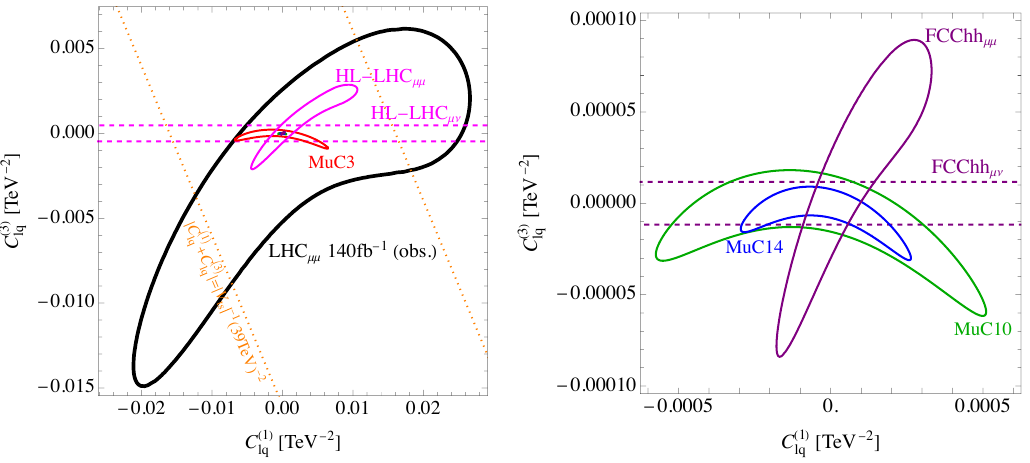
Figure 6 . Sensitivity reach (95% CL) for the quark flavour-universal scenario on the two EFT coefficients C (1) and C (3) , in TeV − 2 , for different colliders. The right plot is a zoomed-in version lq lq near the origin of the left plot. For the future prospects at hadron colliders, we also include the sensitivity on C (3) from the charged-current channel pp → µν (dashed lines), adapting the bound lq from ref. [76]. The dotted orange lines are the solutions of | C (1) illustrate an expectation from the bsµµ anomalies assuming MFV, see eq.